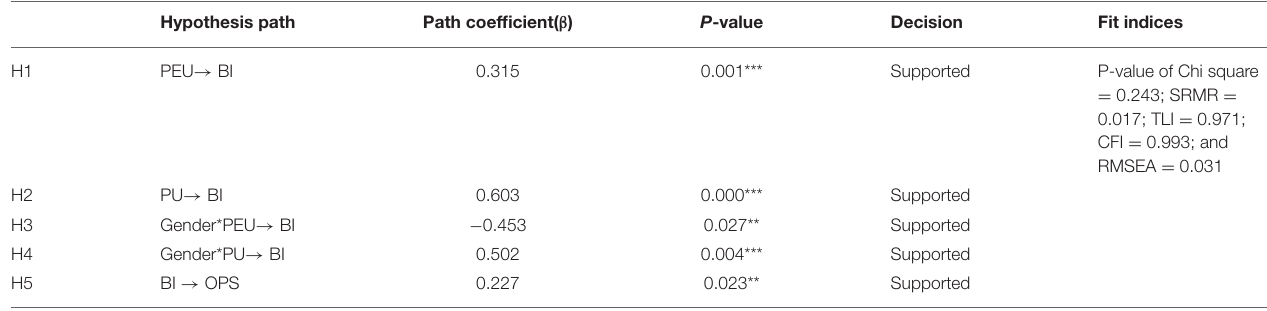
TABLE 5 | Output of the structural model—online payment system adoption in SMEs in